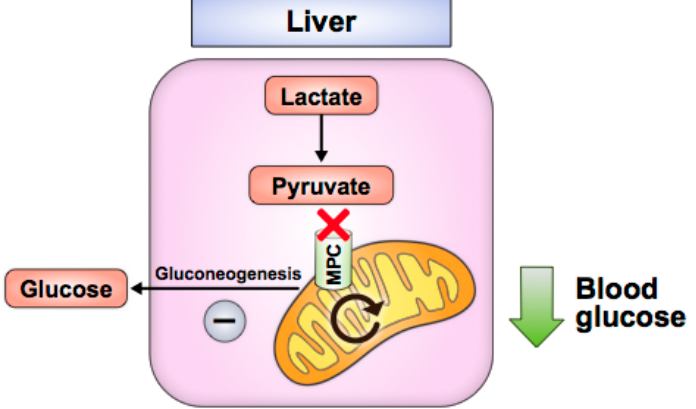
Figure 3. Liver MPC disruption attenuates hyperglycemia by impairing gluconeogenic pyruvate